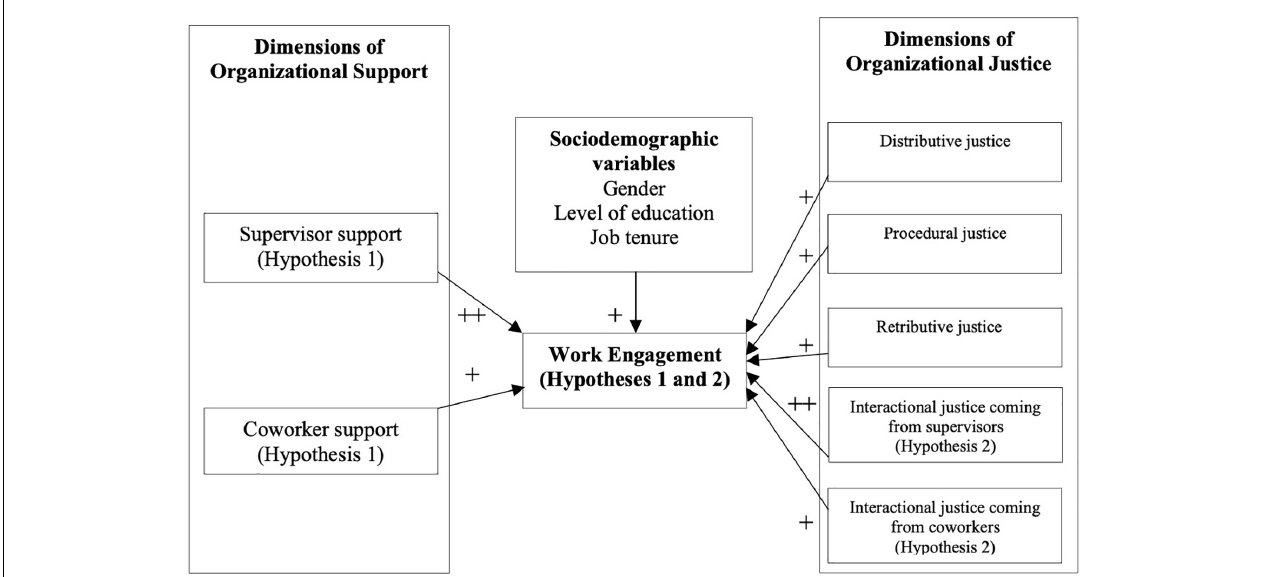
FIGURE 1 | An overview of the conceptual model, hypotheses and variables used in the